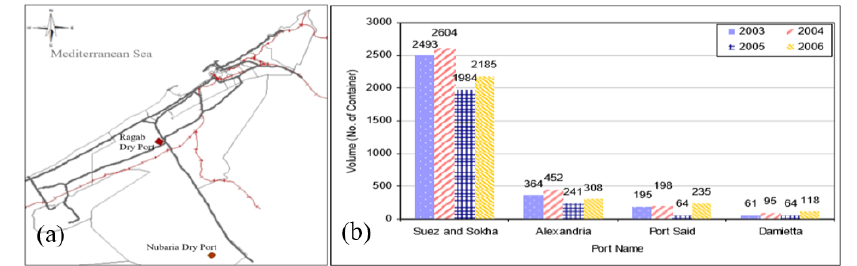
Figure 7. fig. 7a depicts the capacity of dry ports in Egypt from 2003- 2006, (”Japan International Cooperation Agency”, 2008a), fig. 7b depicts the location of the previous initiative dry port in Alexandria.